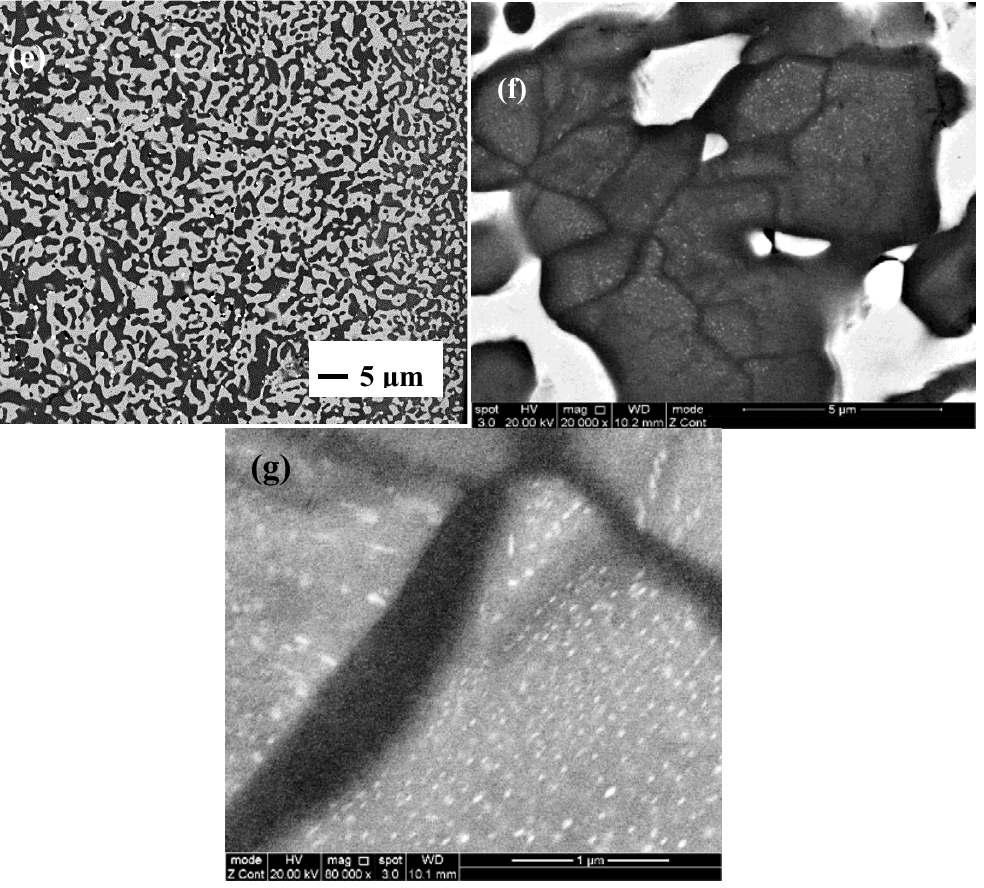
Figure 5. Heat-treated alloy CM1 ( a ), ( b ) and ( g ) 10 g button, ( c ) and ( d ) 6 mm diameter suction-cast bar, ( e ) and ( f ) 8 mm diameter suction-cast bar, ( c ) to ( f ) images from bulk of bars.